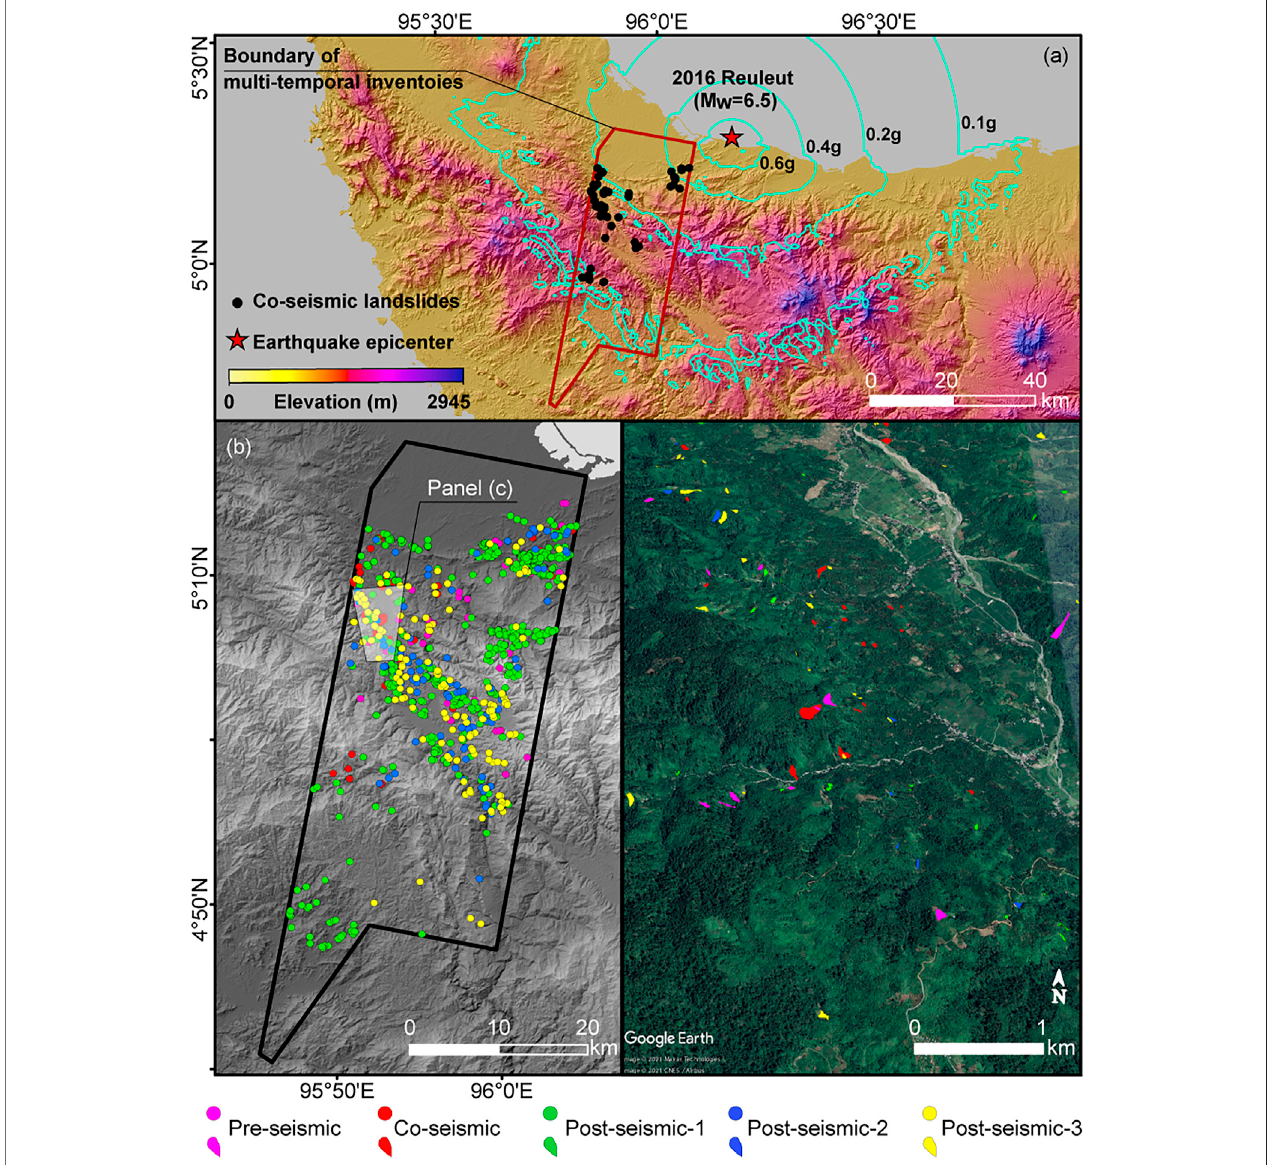
FIGURE2| Mapsshowing (A) arealextentofmulti-temporal inventorieswemappedforthe2017Reuleutearthquake, (B) spatialdistribution ofmappedlandslides and (C) Google Earth scene as a sample view of multi-temporal landslide inventories for a subset of the area. In Panel A cyan contour lines show PGA values are acquired from the USGS ShakeMap system (Worden and Wald, 2016).